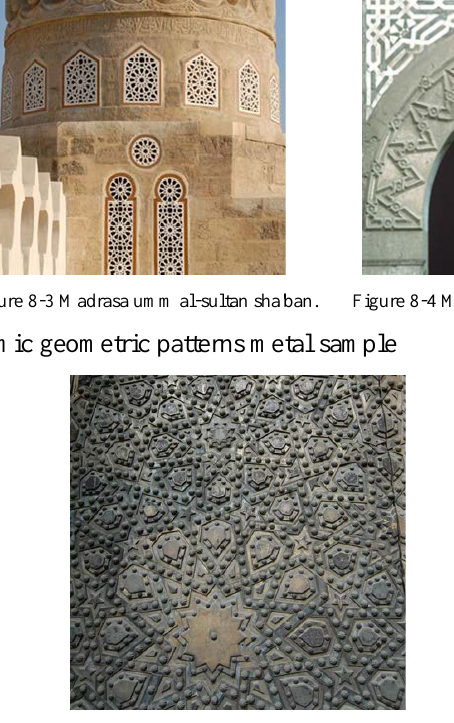
Figure 8-7 bronze door, Sultan hassan mosque. Figure 8-8 bronze door, al-Mu'ayyad Mosque